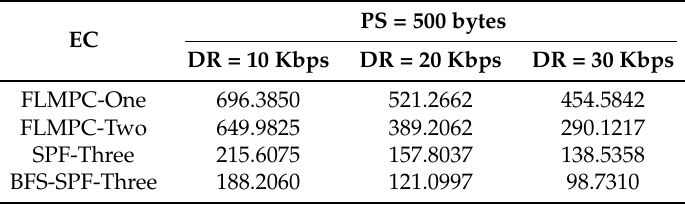
Table 9. EC Values with PS of 500 bytes.